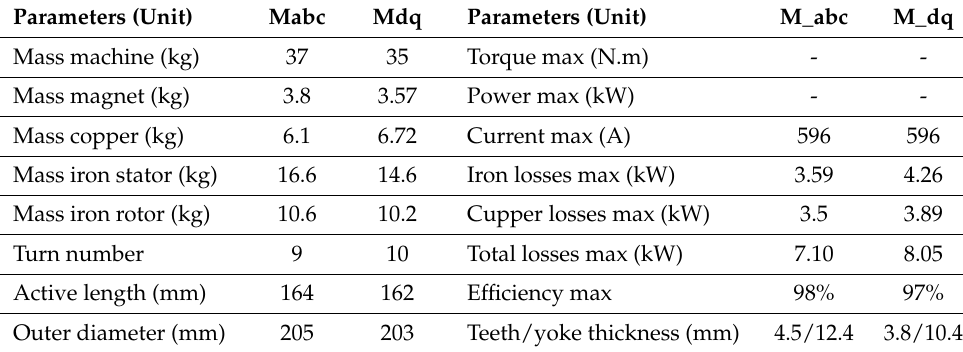
Table 3. Comparison of machines obtained after optimization m_abc vs. m_dq.